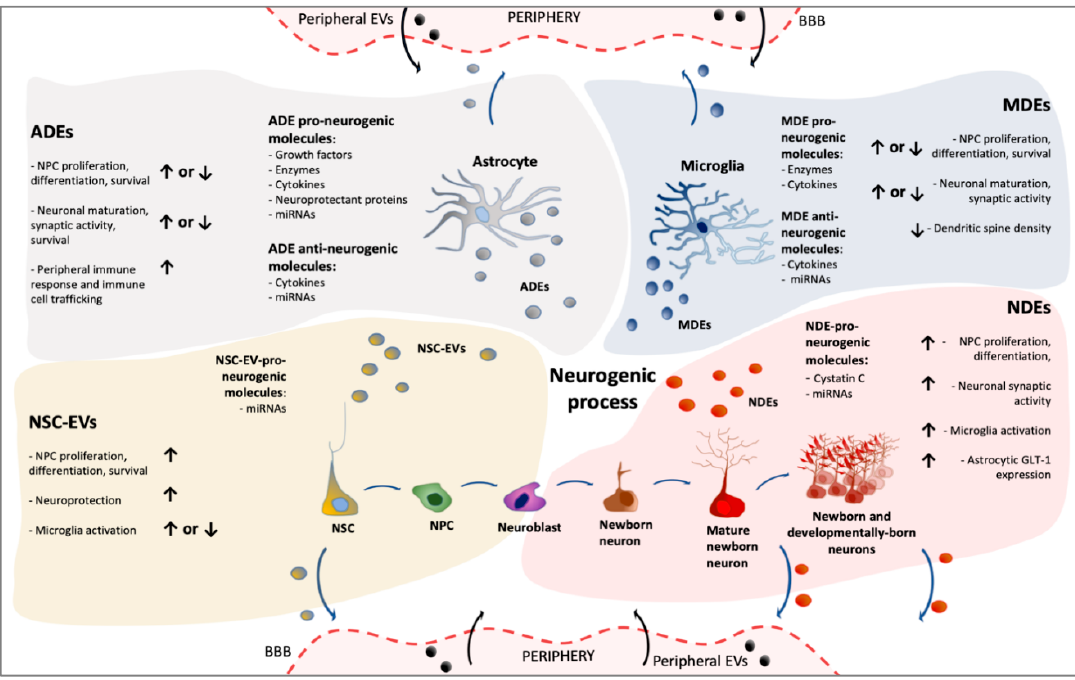
Figure 2. Different layers of complexity in EV-based signalling within neurogenic niches. Schematic representation of the potential impact of EVs generated by distinct cellular components of the niche (NSCs, astrocytes, microglia, neurons) on key steps of the neurogenic process. The nature of the pro- and anti-neurogenic EV-associated molecules is also summarized. Given their ability to cross the blood-brain barrier, EVs derived from niche cells can also exert effects in periphery. Similarly, peripherally generated EVs can reach the adult niche and potentially modulate neurogenesis. (EVs: extracellular vesicles NSC-EVs: neural stem cell-derived EVs; NDEs: neuron-derived EVs; ADEs: